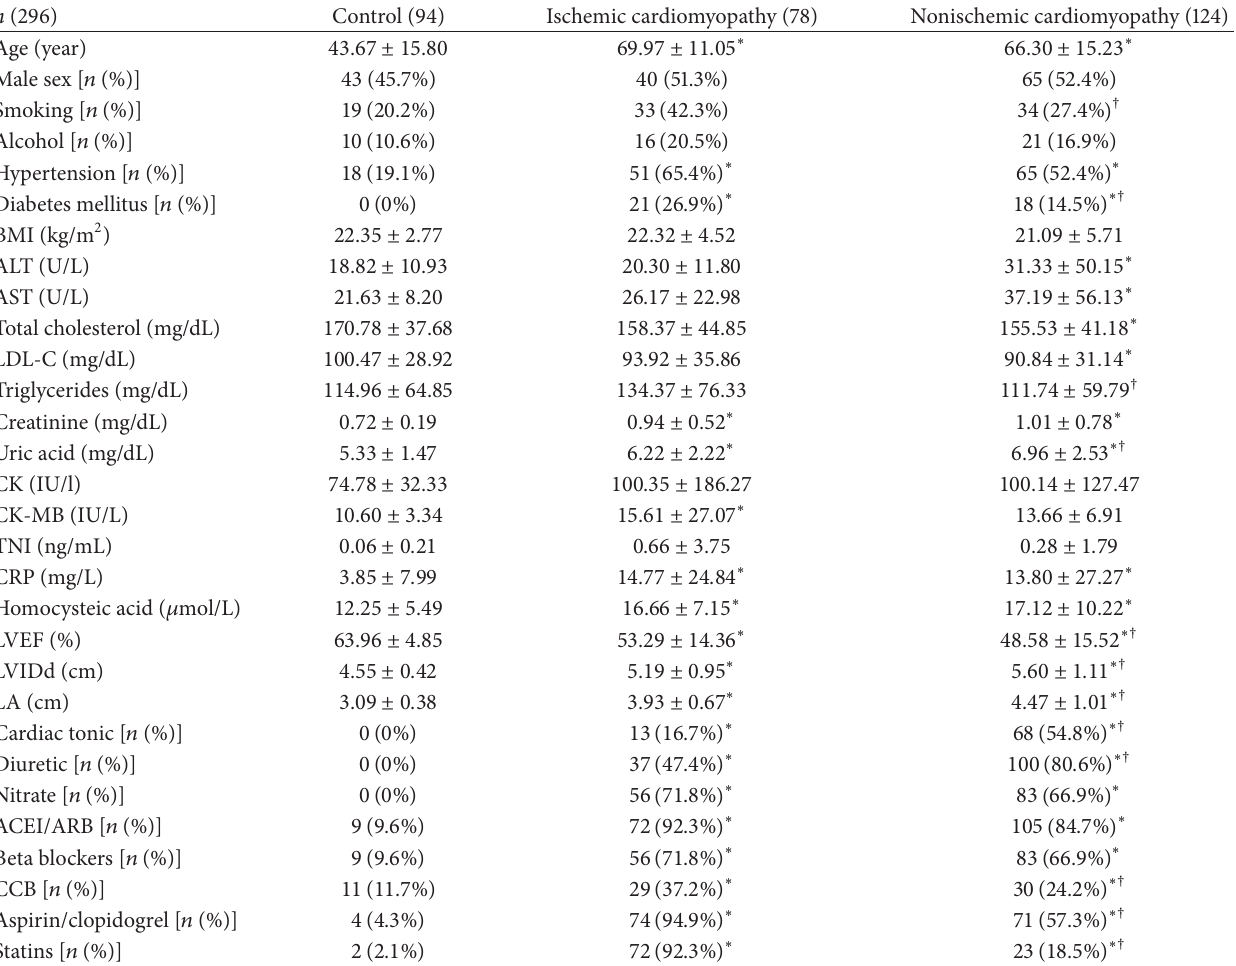
Table 1: Baseline characteristics of the study population between groups.